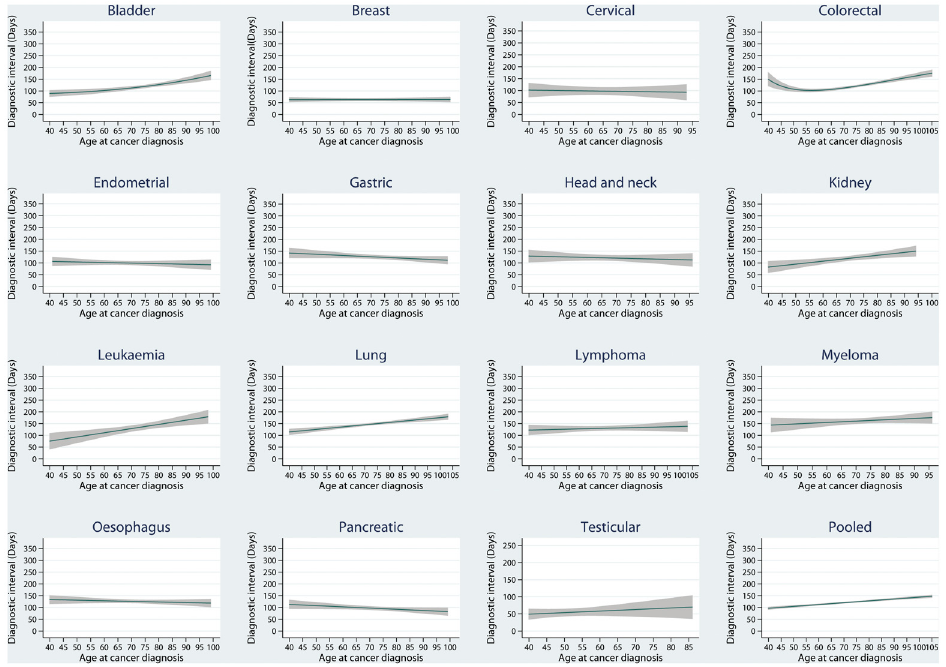
Fig 1. Line graphs to illustrate fitted relationships between diagnostic interval and age.